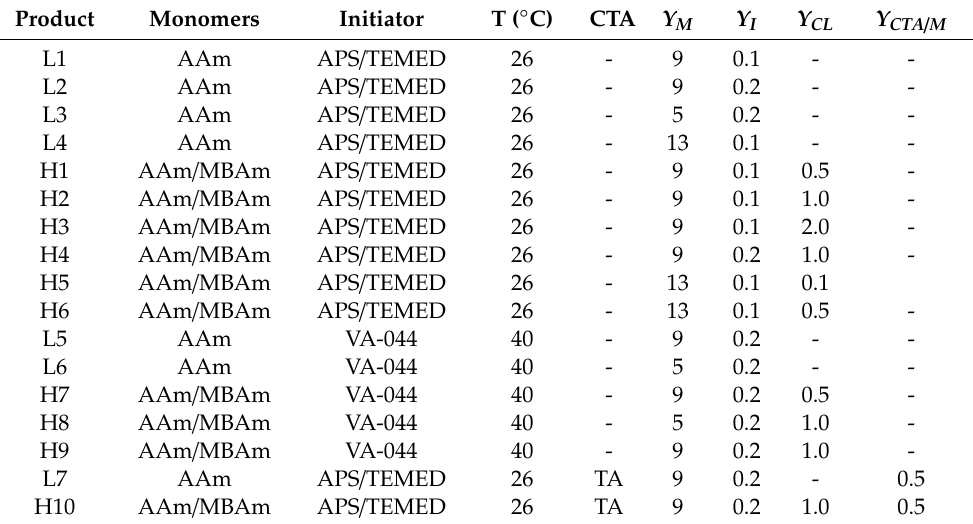
Definitions for the composition parameters described in this table are the following: Y M —mass fraction of acrylamide + methylene bisacrylamide in the solution ( × 100). Y I —mole ratio of initiator compared to acrylamide